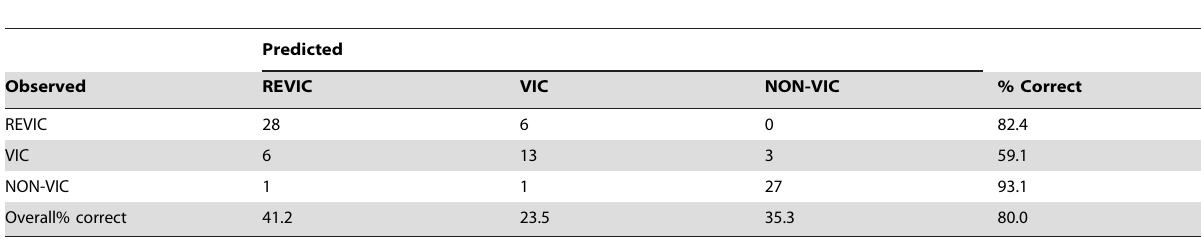
Table 3. Findings of the logistic regression analysis: observed and predicted classifications.